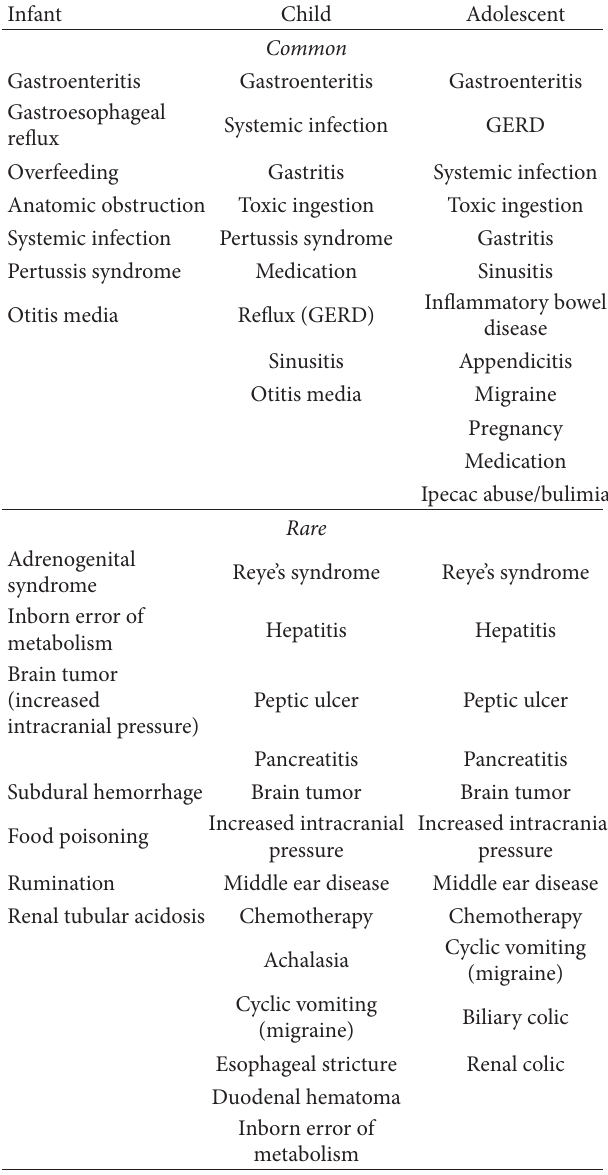
Table 1: Differential diagnosis of emesis during